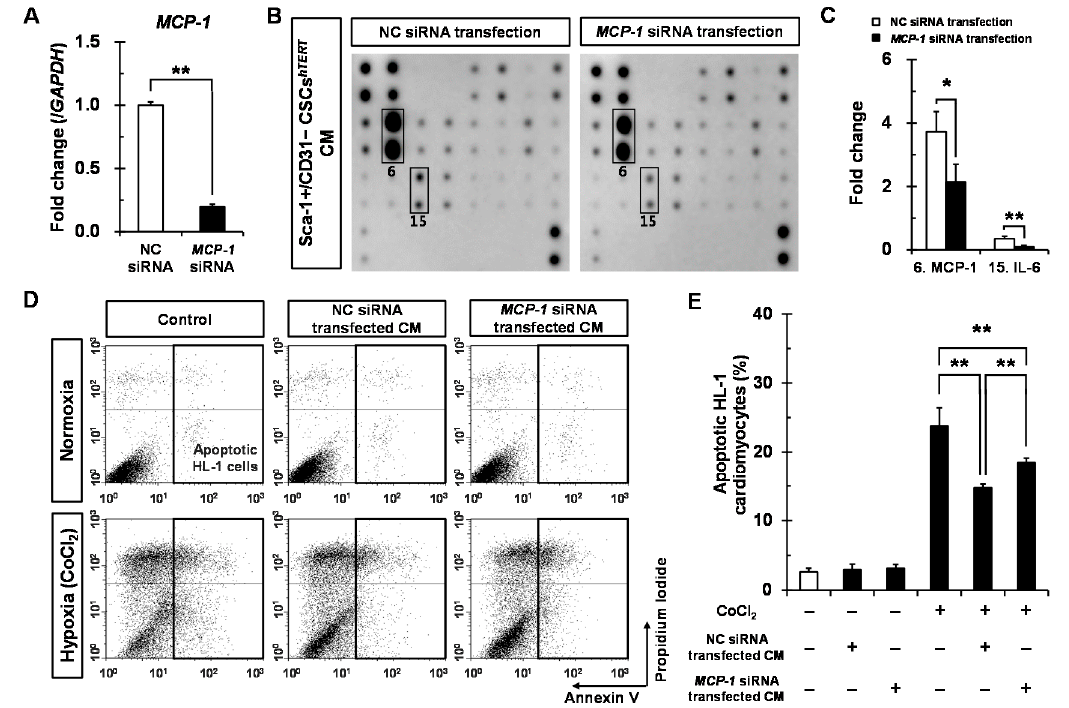
Figure 5. Cont. Figure 5.